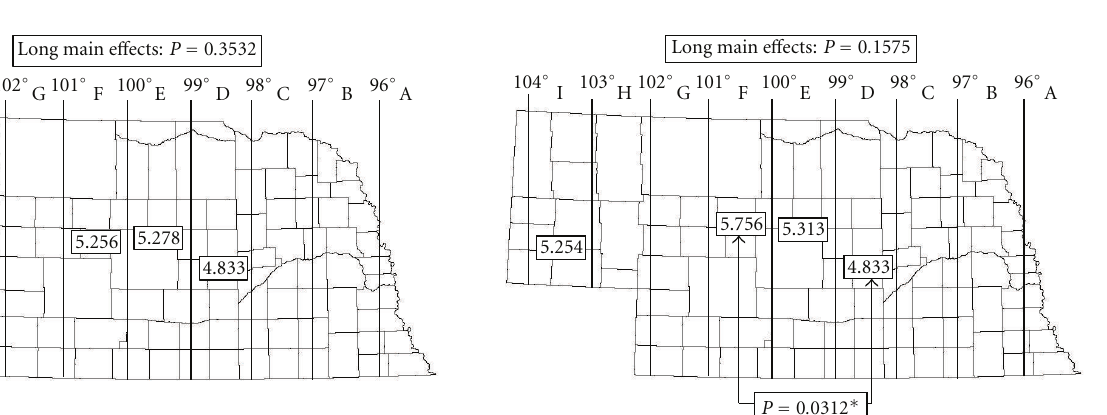
Figure 4: Mean elytral color by code for Cicindela denverensis by longitudinal region. Significant di ff erences between longitudes shown by arrows and mean value presented in each longitudinal grouping. Fixed e ff ects presented at top. No latitude by longitude interactions found.